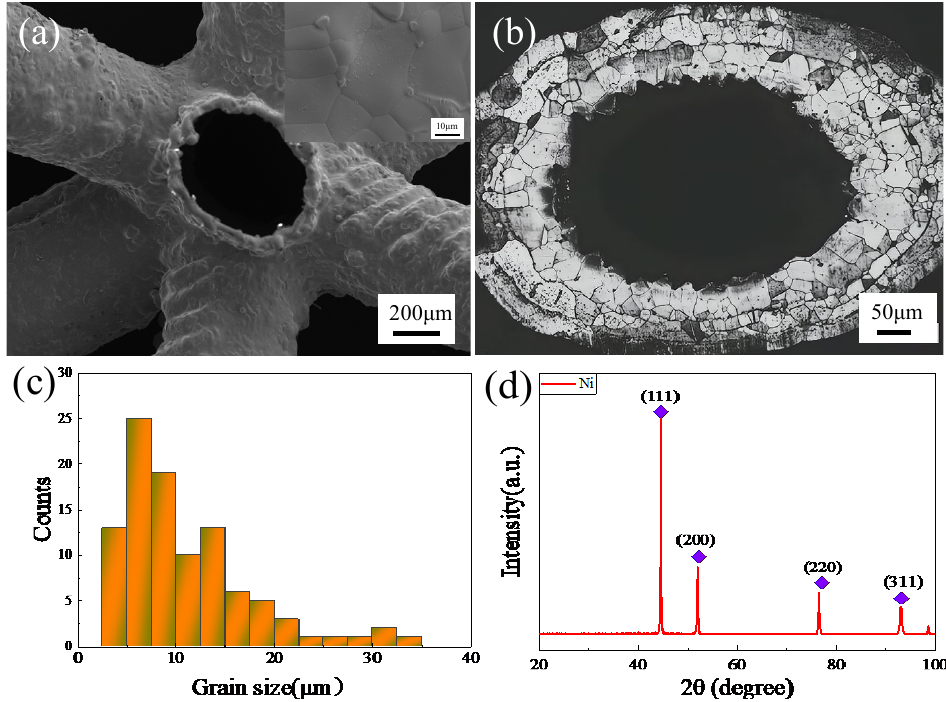
Figure 2. Characterizing the basic properties of pure nickel lattices: ( a ) SEM micrographs; ( b ) optical micrographs of the etched cross section of a lattice strut; ( c ) grain size distribution; ( d ) XRD diffraction spectrum.